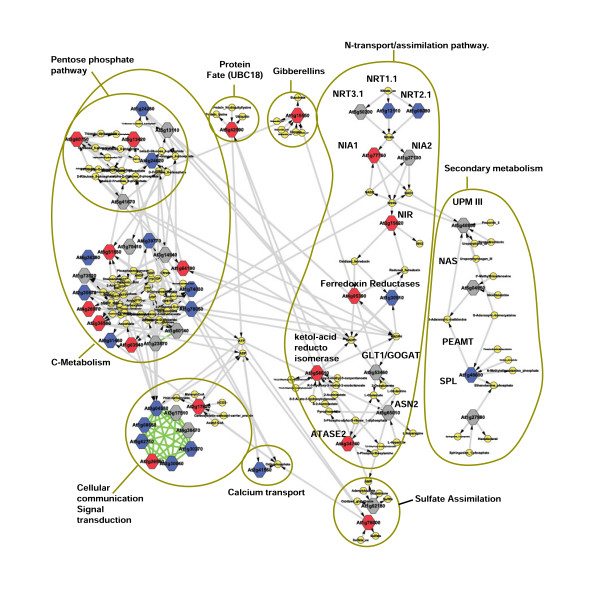
N-bicluster 9 gene network: A highly connected network of biologically related gene functions. The metabolic layer of information about gene connectivity in the Arabidopsis Multinetwork [30] was queried with the 126 genes belonging to the N-bicluster 9. Nodes represent genes (colored squares) and metabolites (yellow circles) connected by edges (metabolic interactions are colored in grey, protein:protein interactions are colored in green). Genes belonging to: i) N-bicluster NO3- exclusive genes are colored in blue, ii) Significant N/H-biclusters are colored in red, iii) Other N/H-bicluster are colored in grey.